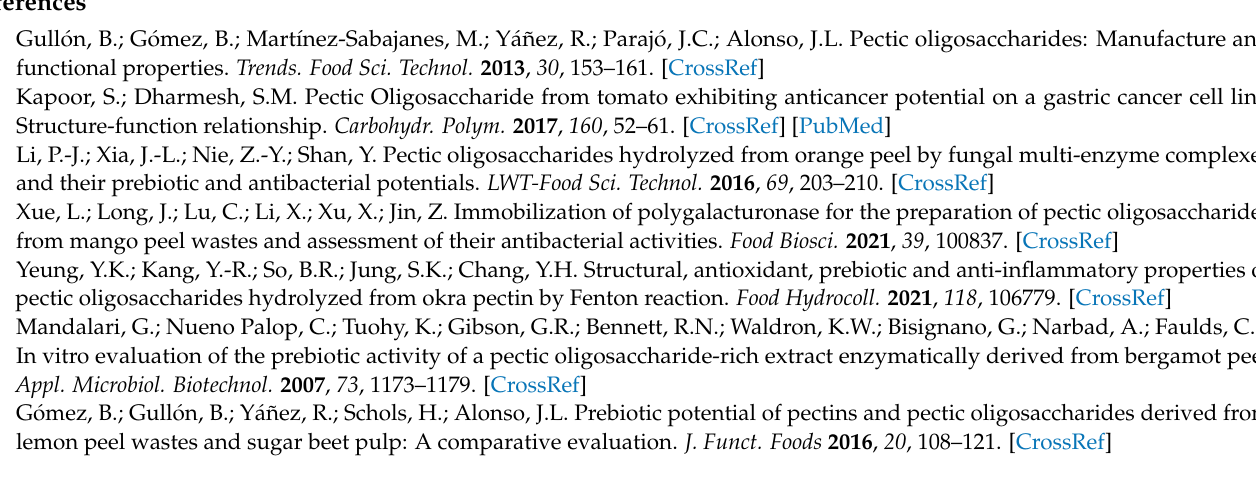
Figure S2: The chromatograms of HPAEC-PAD analysis for hydrolysis products by pePGA on polygalacturonic acid, Figure S3: The high-performance gel filtration chromatography analysis for hydrolysis products by pePGA on polygalacturonic acid and commercial demethylated pectin, Figure S4: TLC analysis of pePGA-POS at different concentrations, Figure S5: Antibacterial activities of pePGA-POS and mono-galacturonic acid against (A) B. subtilis 168; (B) C. albicans ; (C) S. aureus ; (D) E. coli JM109, Figure S6: Antibacterial activities of mono-galacturonic acid against E. coli JM109 and S. aureus , Figure S7: Antibacterial activities of POS from citrus pectin (POS-citrus), POS from apple pectin (POS-apple), mannuronic acid oligosaccharides (MOS) and carrageenan oligosaccharides (COS) against B. subtilis 168, C. albicans , S. aureus and E. coli